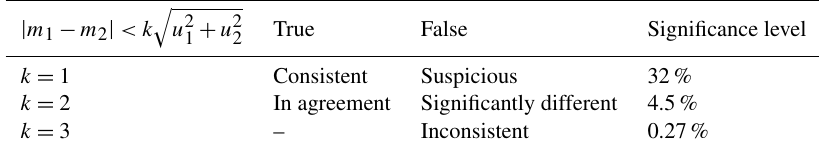
Table 8. Terminology for pair checking in independent measurements with identical quantities for consistency.